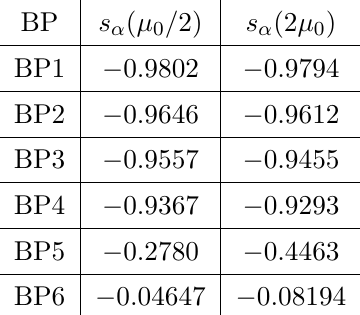
Table 7. Running values for s (cid:11) in the HSESM at the scales (cid:22) 0 = 2 and 2 (cid:22) 0 . The benchmark points are de(cid:12)ned at the central scale (cid:22) 0 in table 5.